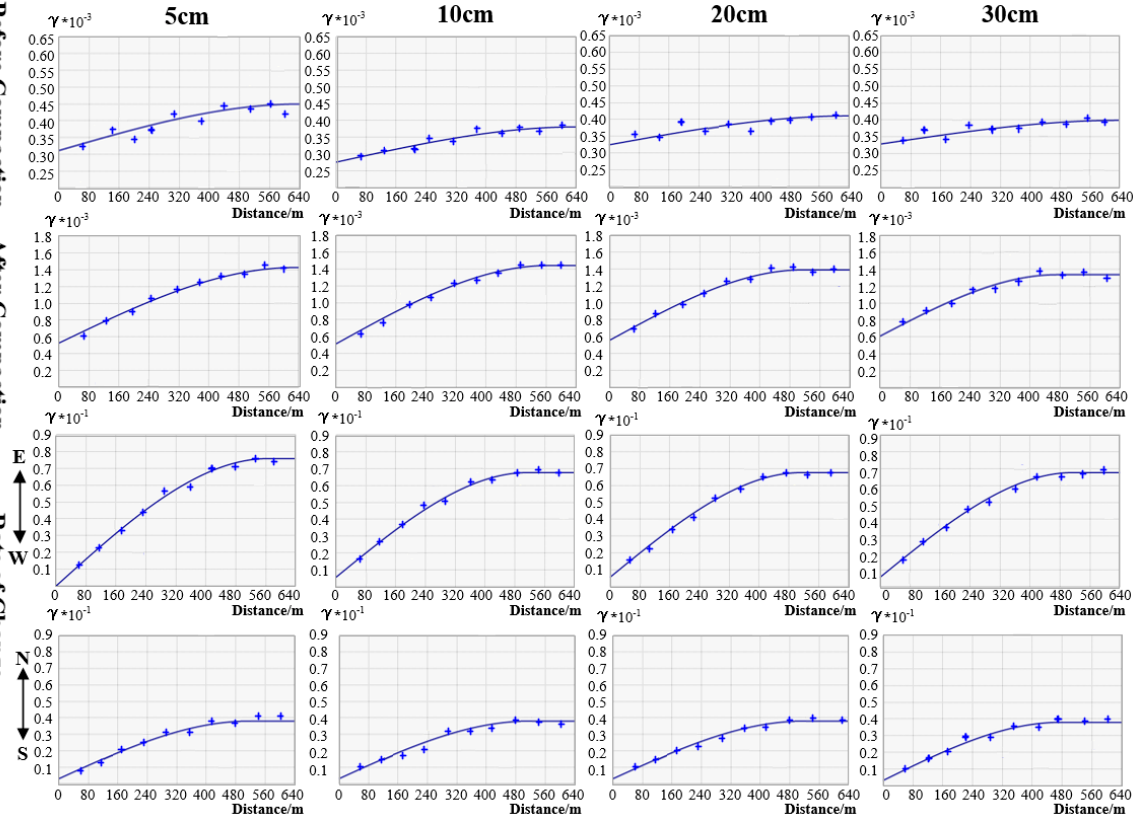
Figure 9. Transverse spatial semi − variance functions for soil compactness at various depths before and after compaction.